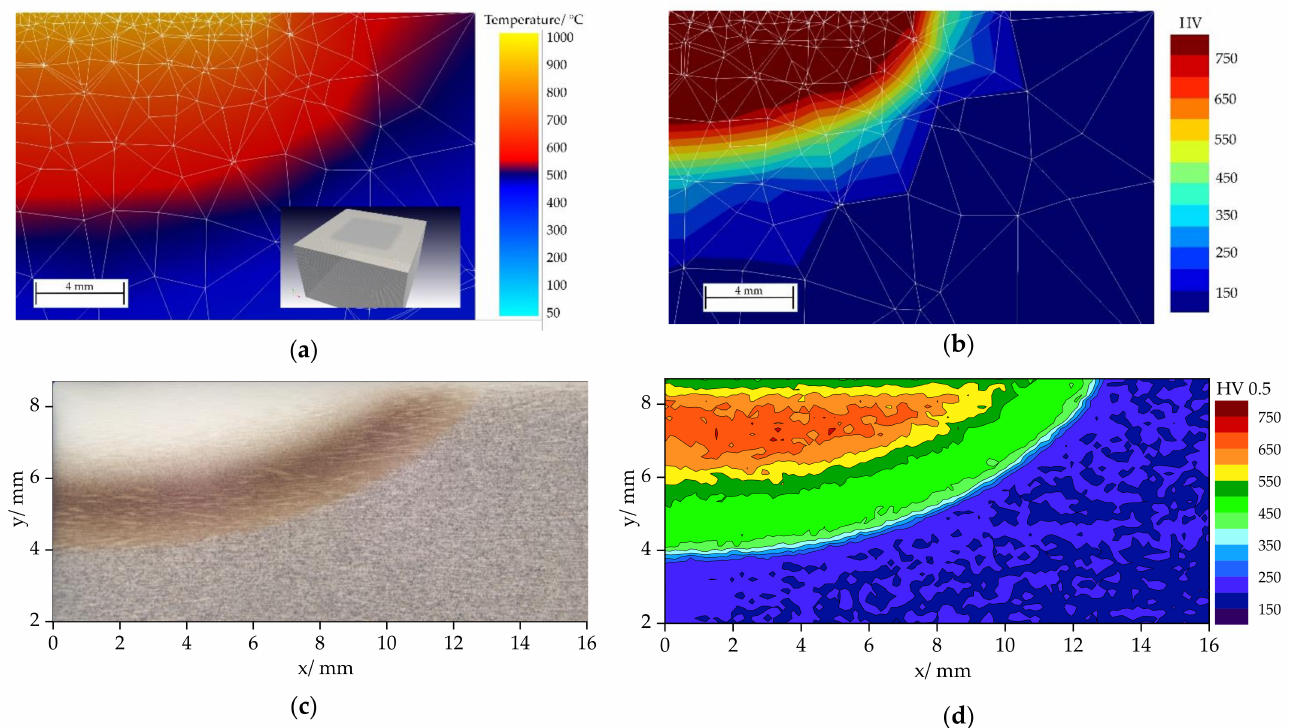
Figure 10. Example of a simulated temperature distribution (sample size 40 mm × 40 mm × 25.4 mm) during heating using static transient heat source ( a ), the belonging calculated hardness distribution after cooling down ( b ), the corresponding cross-section polish of the real treated sample ( c ) and the belonging two-dimensional hardness distribution measured with UCI ( d ).